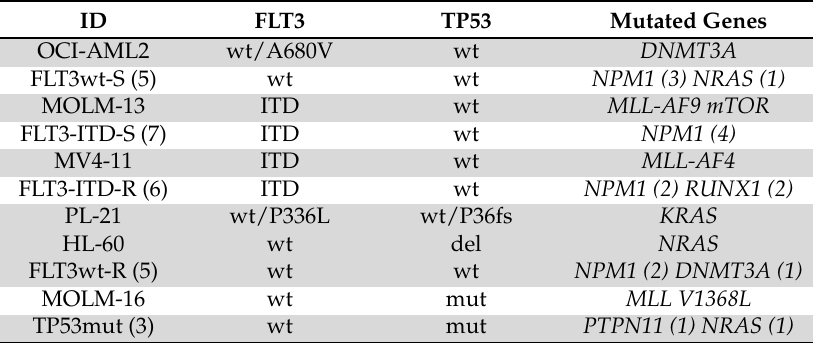
Table 1. Acute myeloid leukemia (AML) cell lines and patient